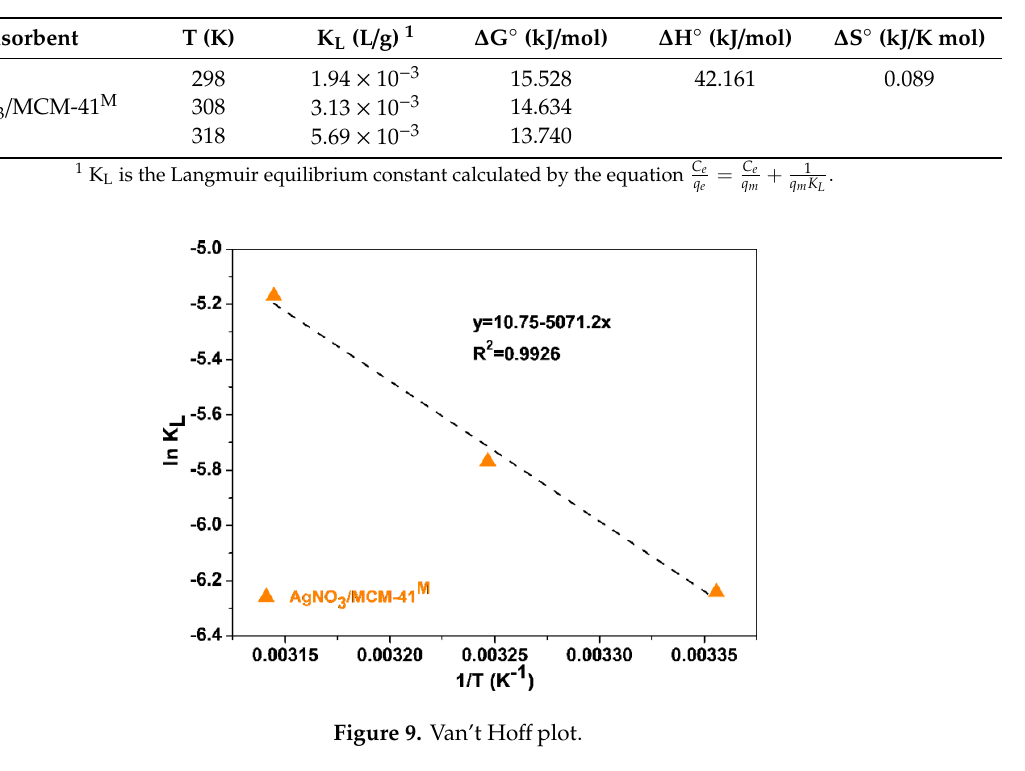
Table 5. Thermodynamic parameters for sulfur adsorption on AgNO 3 / MCM-41 M . Experimental conditions: room pressure, real diesel with sulfur concentration ranging from 25 to 500 ppm.